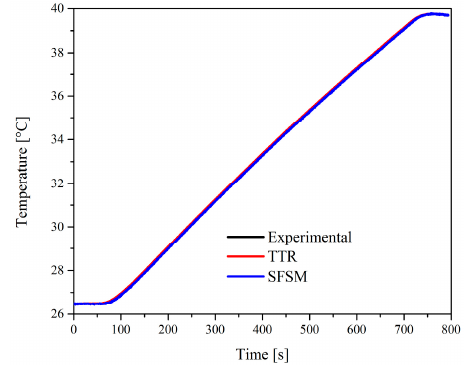
Figure 8. Comparison between the experimental and calculated temperatures.